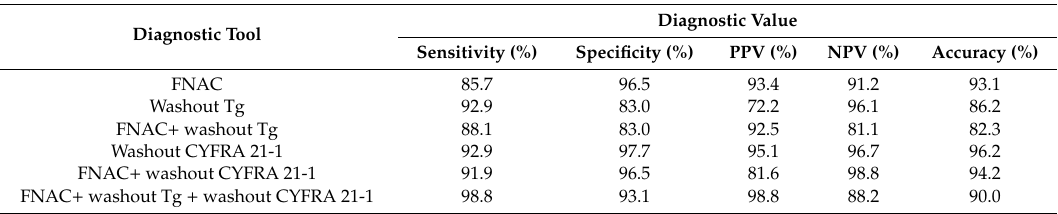
Table 3. Comparison of diagnostic performance of FNAC, washout Tg, washout CYFRA 21-1, combined with FNAC and washout Tg, combined with FNAC and washout CYFRA 21-1 and combine with all modality.